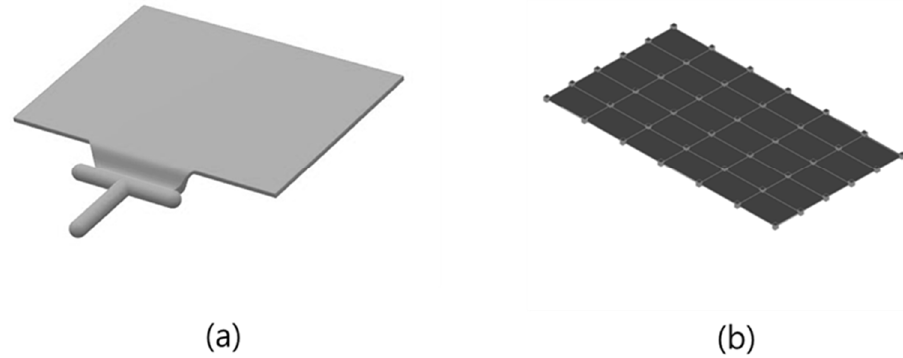
Figure 2. Plate specimen: ( a ) model; ( b ) geometry for mode shape.